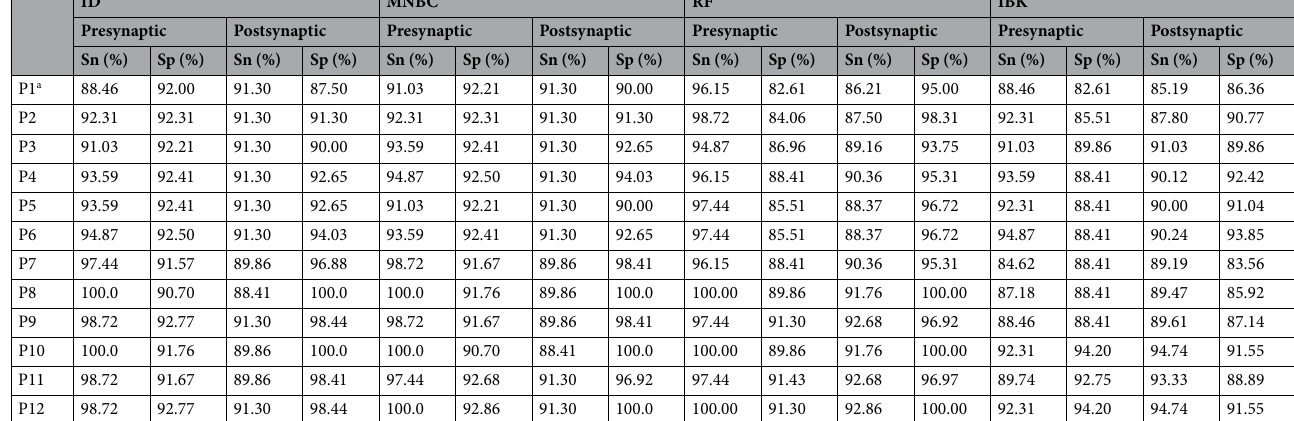
Table 1. Results obtained by ID, MNBC, RF and IBK in identifying presynaptic and postsynaptic neurotoxins with 12 parameters. a Come from 30 by using Increment of Diversity (ID).